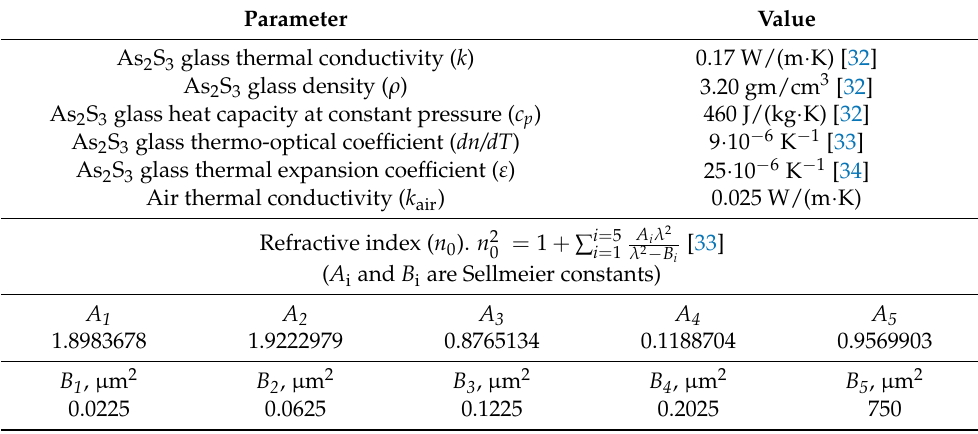
Table 1. Parameters used in simulations. Parameter Value As 2 S 3 glass thermal conductivity ( k ) 0.17 W/(m · K) [32] As 2 S 3 glass density ( ρ ) 3.20 gm/cm 3 [32] As 2 S 3 glass heat capacity at constant pressure ( c p ) 460 J/(kg · K)